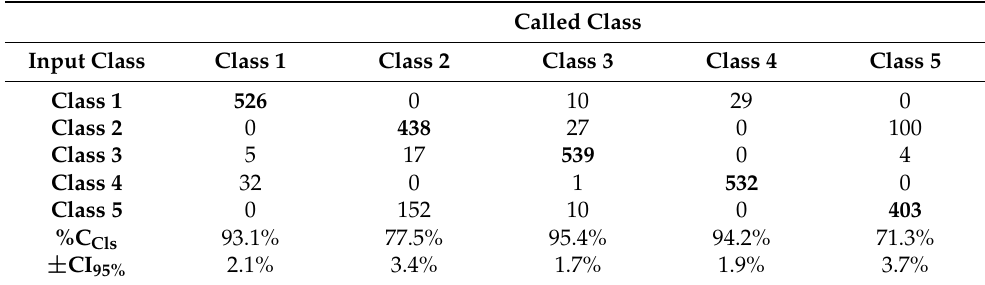
Table 3. Classification confusion matrix for model M1 (D1, D2, D3, D4, D5) in Table 2 showing N Cls = 5 discrimination performance for SNR = − 20 dB